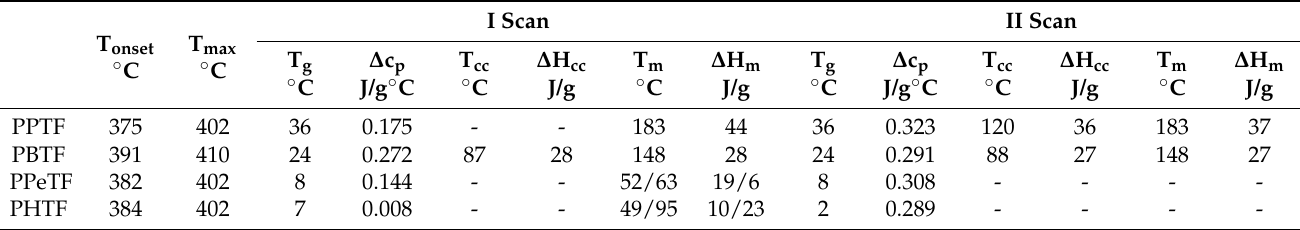
Table 2. Thermal characterisation (TGA and DSC) data of the homopolymers under study in the form of compression- moulded